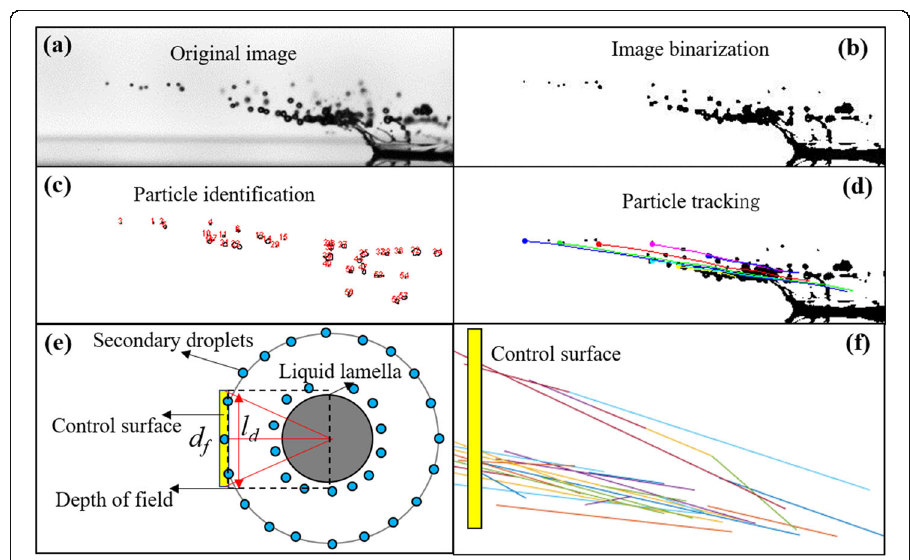
Fig. 2 Schematic diagram of image processing: a - d represent the image processing steps: image binarization, particle identification, particle tracking. e and f represent the geometrical relationship for estimating the total splashing